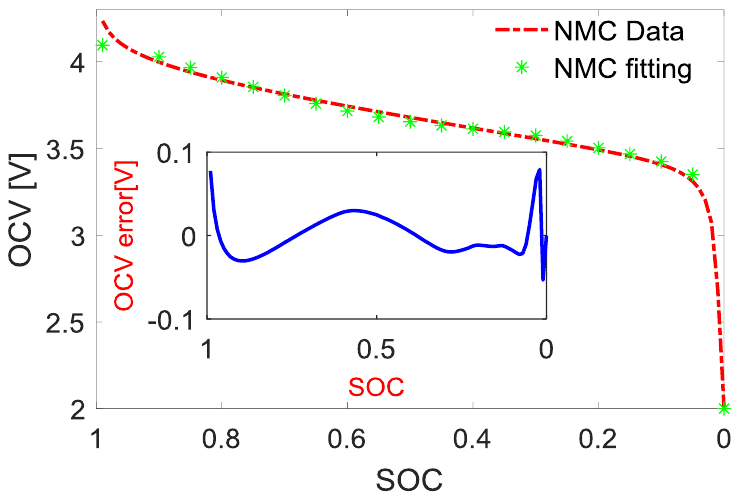
Figure 4. The experimental and fitted OCV–SOC curves and the variation of OCV error at 30 °C.